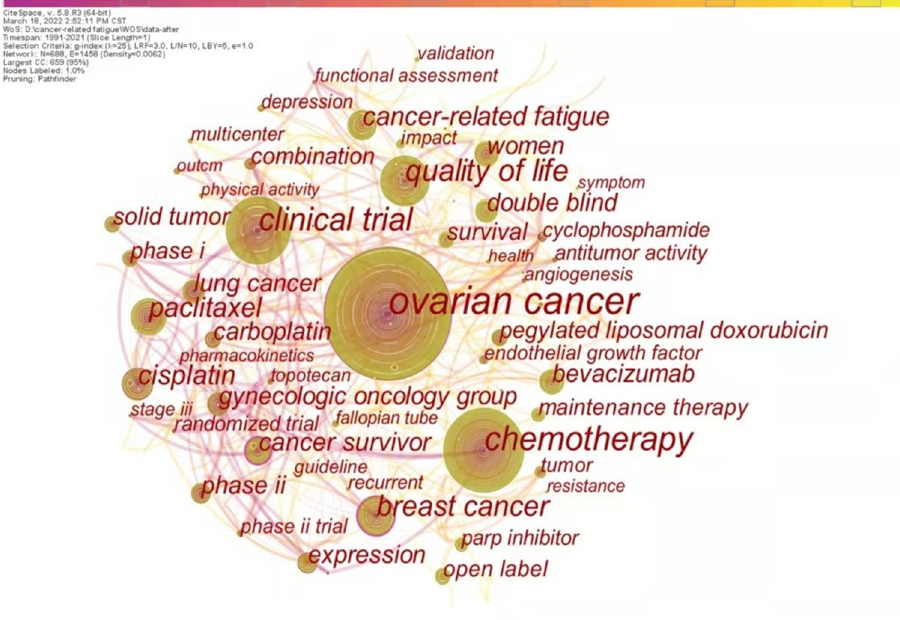
Fig 5. Map of keyword co-occurrence network in cancer-related fatigue in ovarian cancer